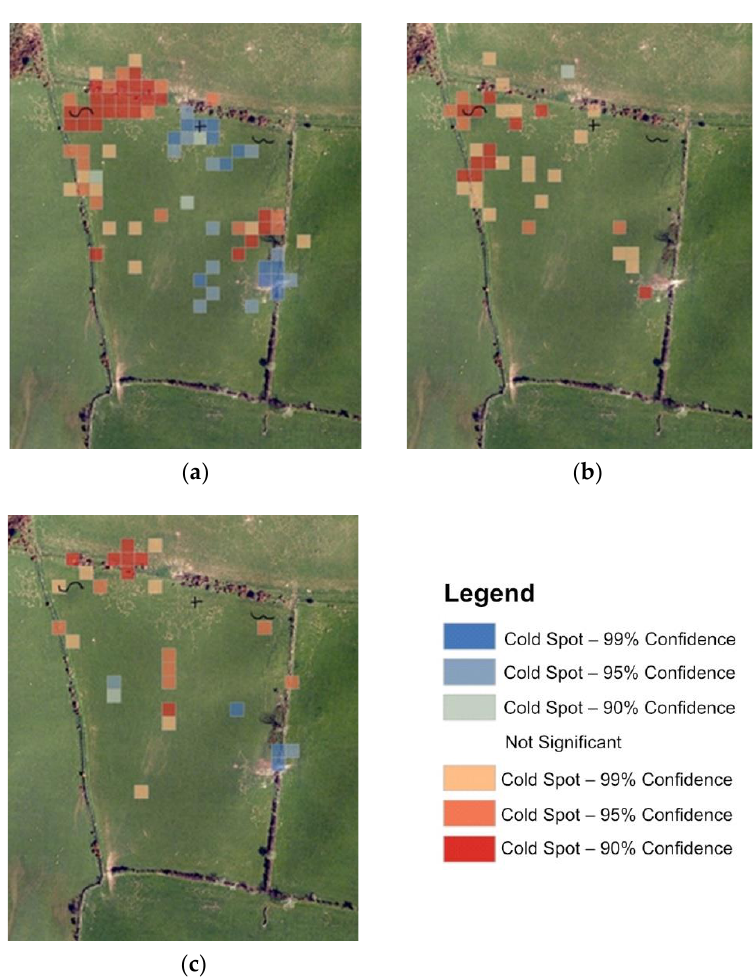
Figure 4. Getis-Ord Gi* Hotspot Analysis of wind speed during 8 h windows ( a ) 00:00–08:00 ( b )